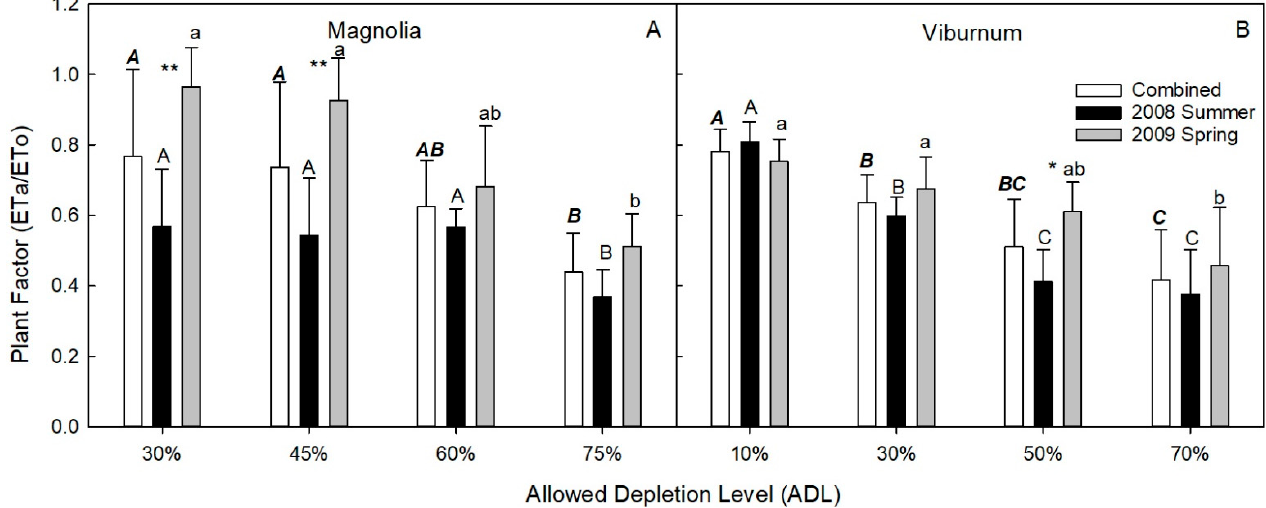
Figure 4. Effect of allowable depletion level (ADL) on plant factor (normalized lysimeter plant water use ETa ÷ reference evapotranspiration ET O ) for the southern magnolia ( Magnolia grandiflora , n = 4) and sweet viburnum ( Viburnum odoratissimum , n = 3) growing in lysimeter containers and subjected to four levels of allowable soil water depletion levels (ADL) for spring and summer study periods, and combined for an average PF ( n = 8, 6 respectively). ( A ), Plant Factor of magnolia in the 2008 summer, 2009 spring and from both periods of time combined contrasted with Allowed Depletion Levels (ADL); ( B ), Plant Factor of viburnum in the 2008 summer, 2009 spring and from both periods of time combined contrasted with ADL; Asterisks above the summer and spring experiment columns indicate significant seasonal differences at the 0.01 (**) and 0.05 (*) probability level. Columns showing mean separation letters ab, A–B or A – B are significantly different at p < 0.05 across ADL treatments for the 2008 summer, 2009 spring, and both periods combined, respectively.